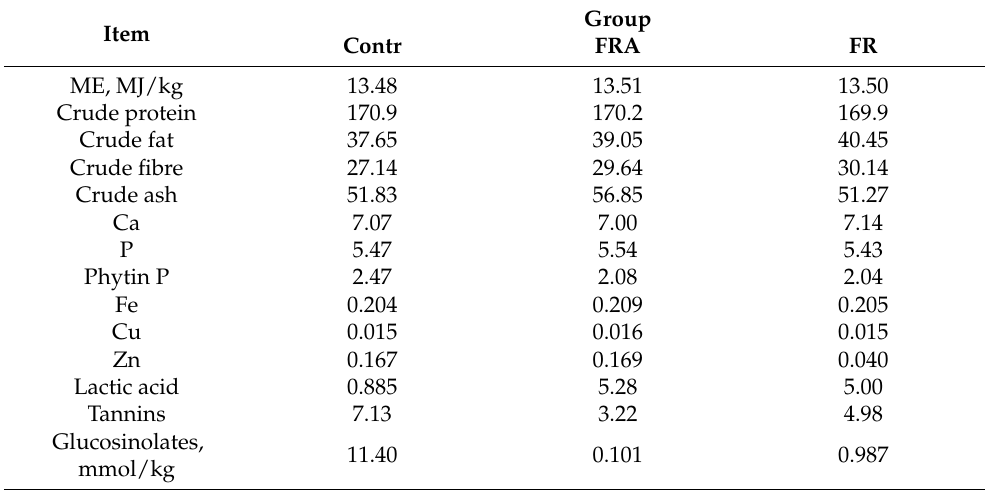
Table 2. Metabolized energy (ME, MJ/kg) and chemical composition (g/kg) of experimental diets